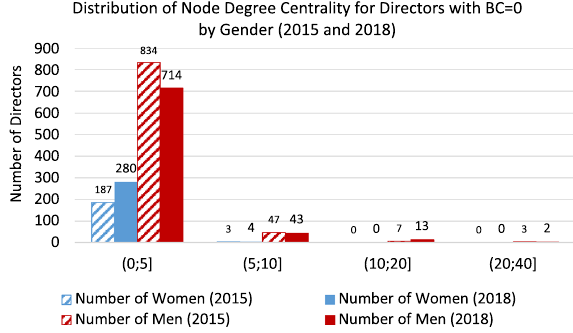
0 by Gender (2015 and =